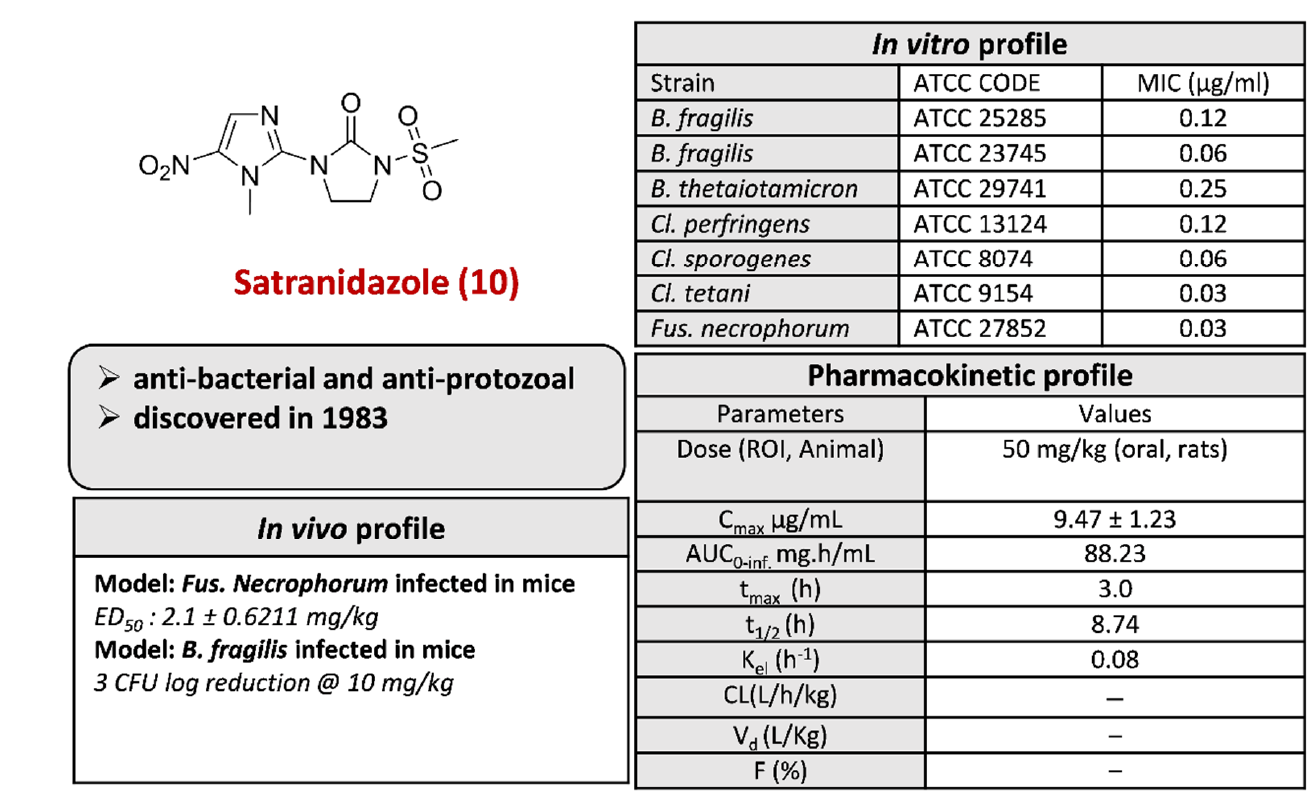
Figure 14. Activity profile of Satranidazole 10 [29,101].